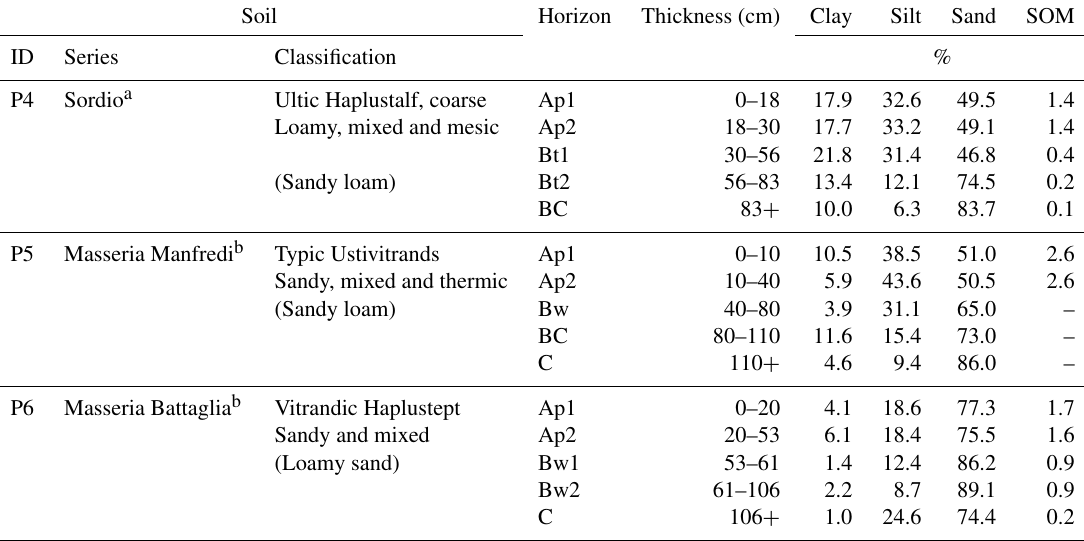
Table 1. Physical characteristics and classifications of the three Italian soils being studied (from Bonfante et al., 2020) Note: SOM – soil organic